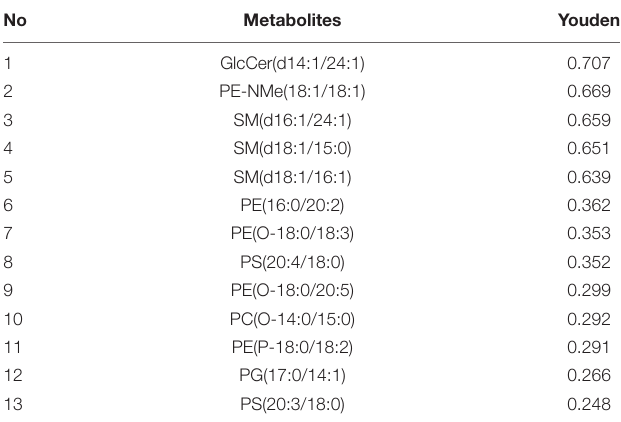
TABLE 3 | Diagnostic performance of serum biomarkers in discriminating papillary thyroid carcinoma from healthy controls.